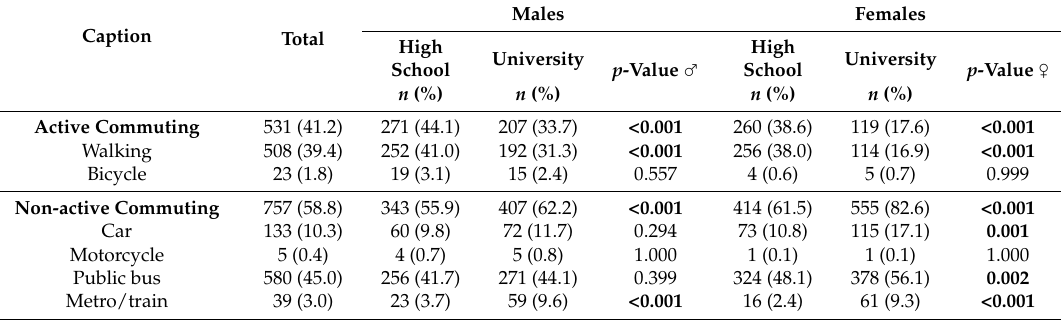
Table 3. Commuting mode that students use from high school and university to home.